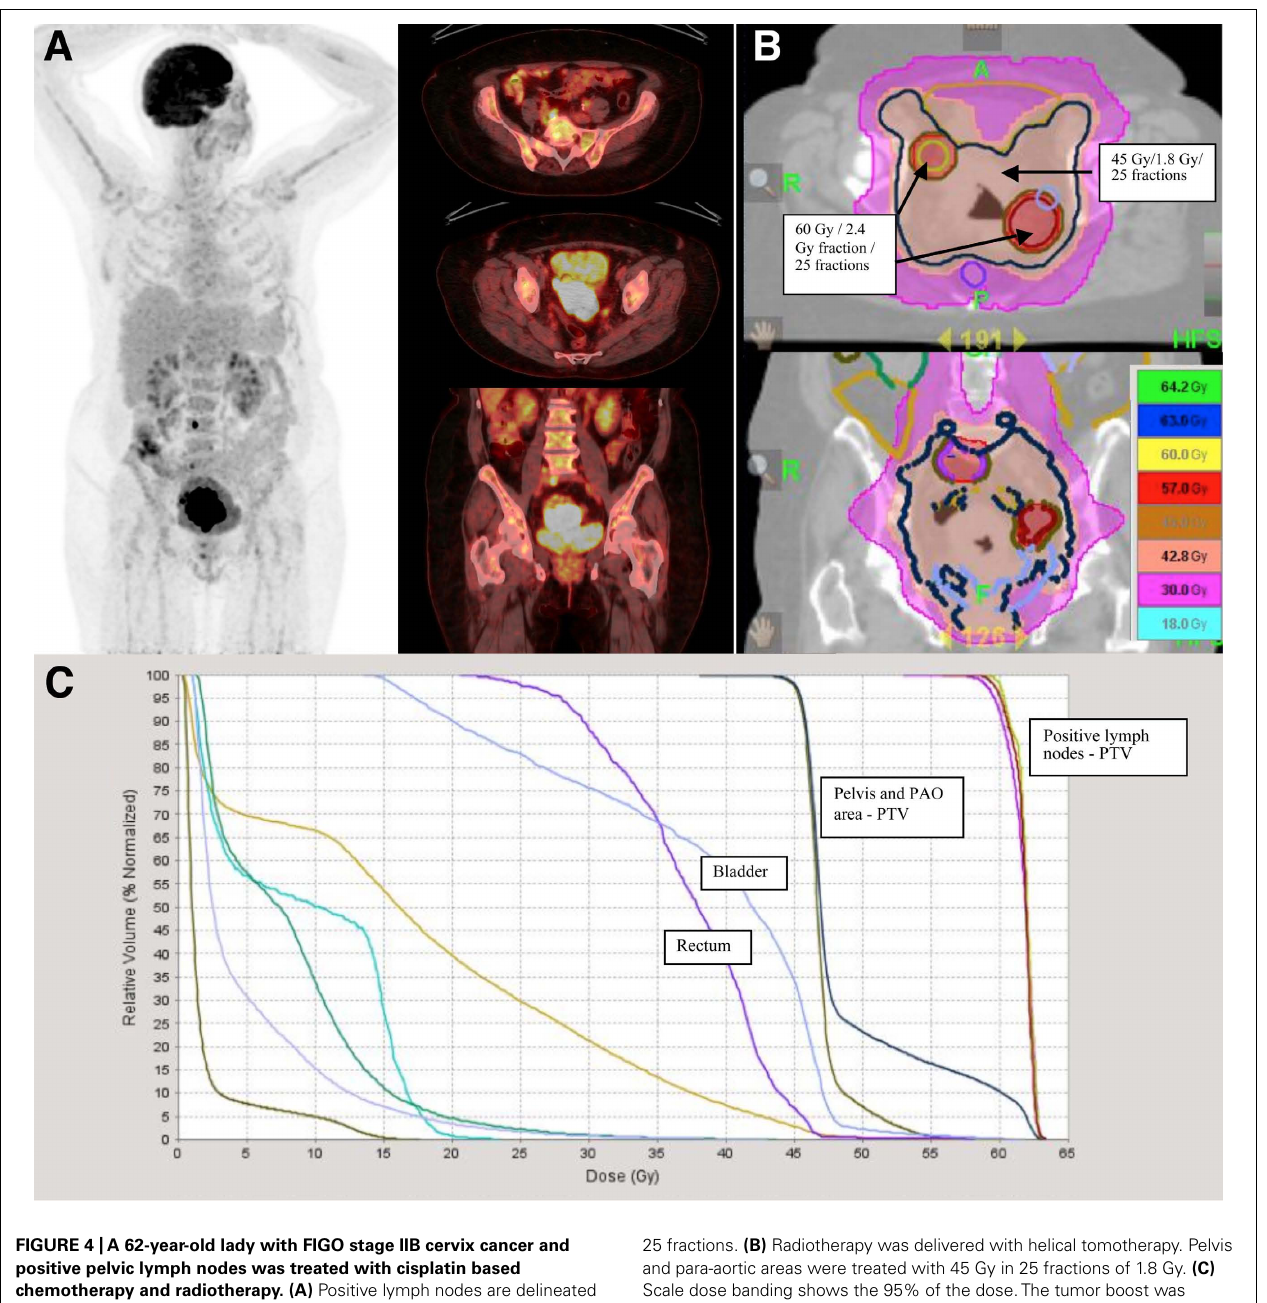
25 fractions. (B) Radiotherapy was delivered with helical tomotherapy. Pelvis and para-aortic areas were treated with 45 Gy in 25 fractions of 1.8 Gy. (C) Scale dose banding shows the 95% of the dose.The tumor boost was delivered with MRI-guided brachytherapy in four fractions of 7